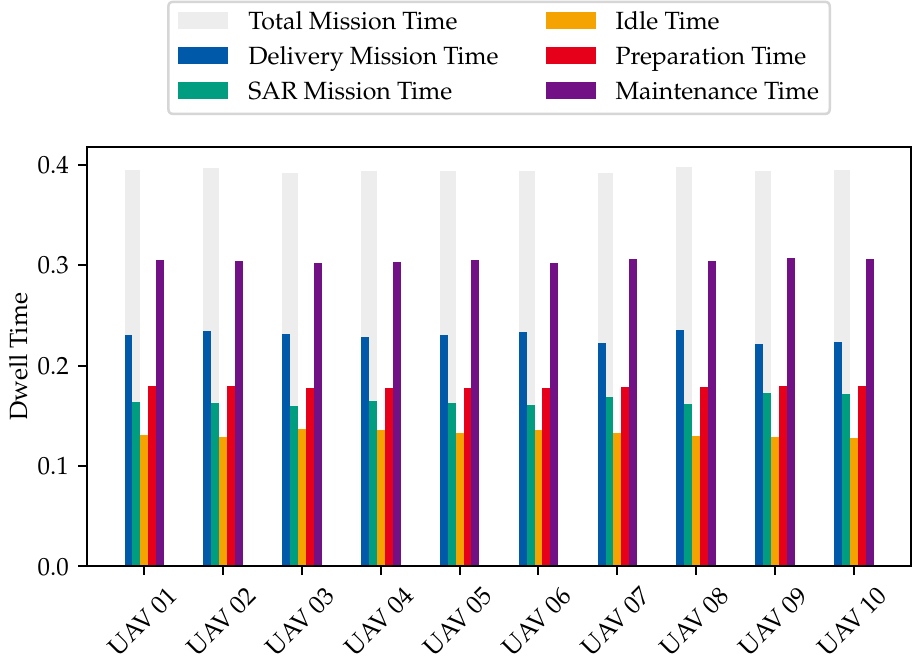
Figure 8. Evaluation of fleet usage with a predetermined maintenance